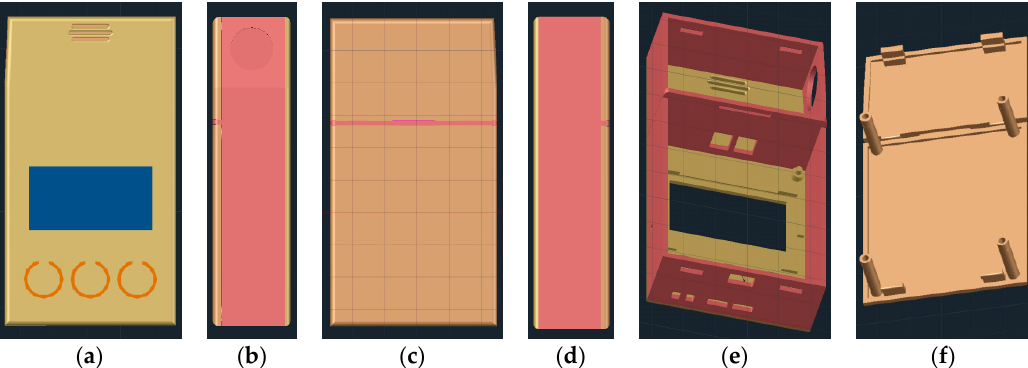
Figure 2. 3D view and projections of the developed housing for the portable gas analyzer designed using CAD software. The housing is comprised of two parts: a front piece with user interface elements (a), mouthpice port (b), USB port and μ SD card slots and back panels (c, d) allowing easy assembly (clips and slots) and access inside the device (e, f ). Total dimensions are 95.2 mm × 23.7 mm × 51.6 mm.